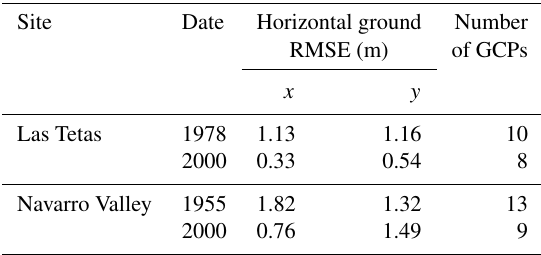
Table 1. Errors generated during the aerial photo processing. The ground root mean square error (RMSE) relates to sets of ground control points (GCPs) extracted from the Geoeye orthoimage and used for the orthorectification of the aerial